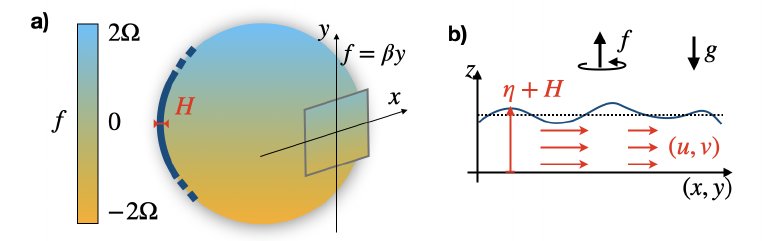
Figure 1: a) The Coriolis parameter f as a function of latitude on a rotating planet, and the shallow water model with H the fluid layer thickness, much smaller than the typical horizontal scales of motion. b) Beta-plane approximation: the flow takes place in a plane ( x , y ) tangent to the equator, with f = β y .